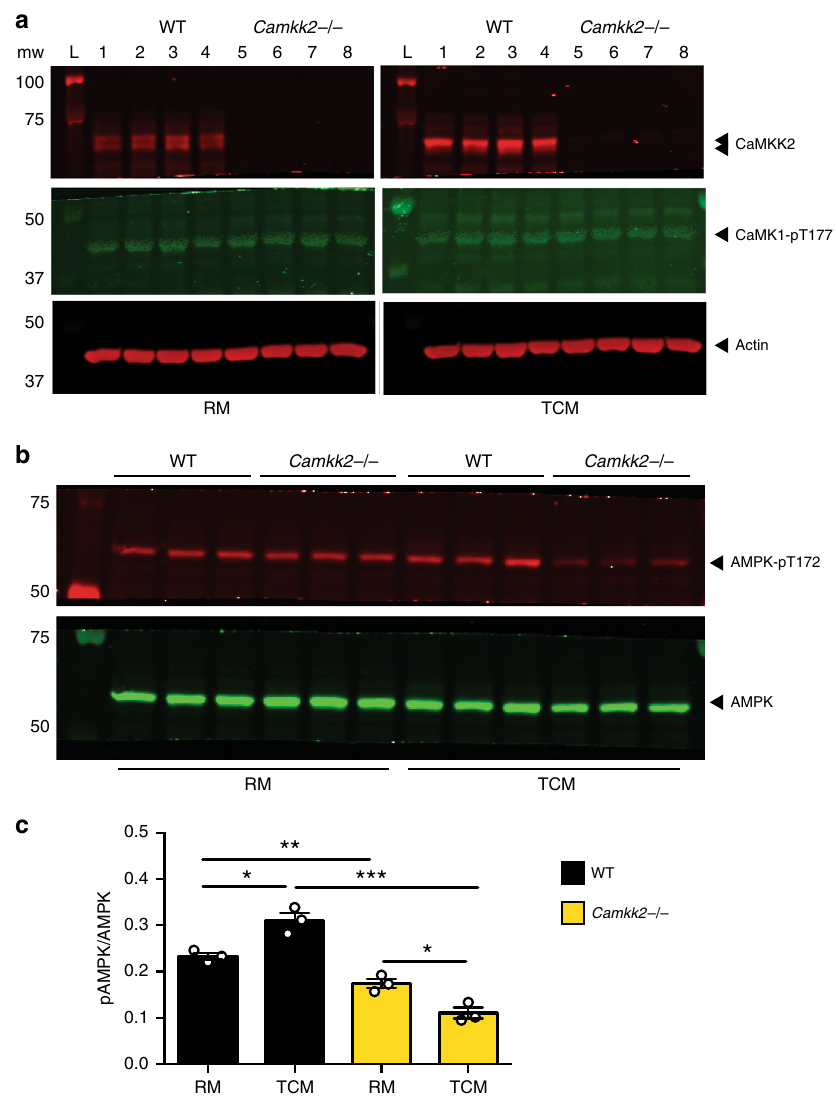
Fig. 5 CaMKK2 links tumor factor signaling to AMPK activation. WT and Camkk2 − / − BMDM were generated in regular differentiation medium in the presence or absence of E0771-conditioned medium (RM and TCM, respectively). a CaMKK2 and phospho-CaMK1 immunoblots. b Expression of phosphorylated (T-172; p-AMPK) and the total AMPK α was assessed by immunoblot. c Quanti fi cation of p-AMPK/AMPK ratio ( N = 3 biological replicates; mean ± SEM). Each lane refers to protein lysate extracted from a single biological replicate. A t test was used to calculate p -values. Asterisks refer to * p < 0.05, ** p < 0.01, and *** p < 0.005,